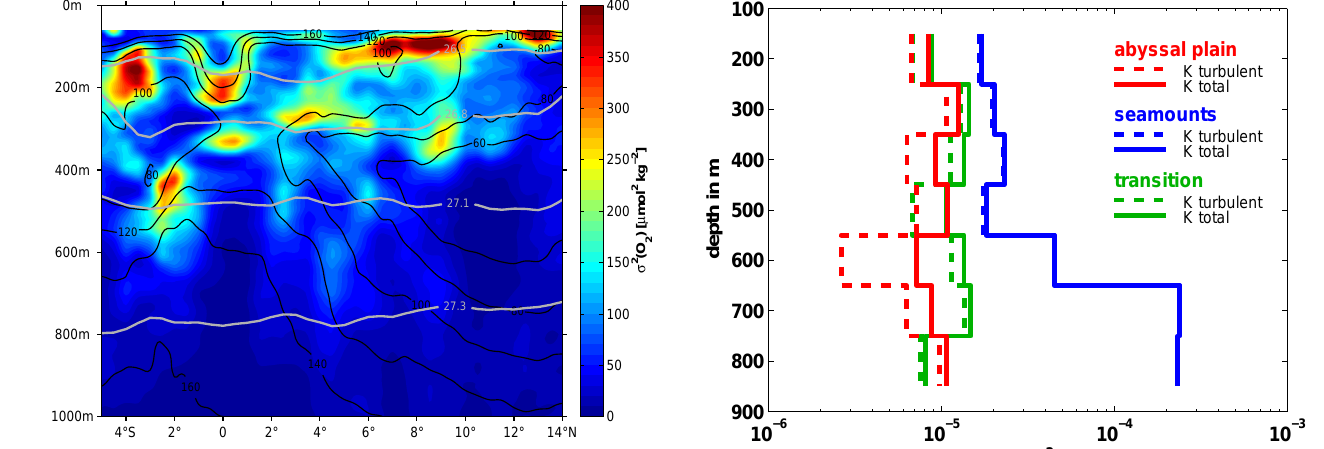
Figure 10. Oxygen variance along 23 ◦ W from repeat ship sec- tions. The analysis was done on isopycnal surfaces and the re- sults were projected back onto depth coordinates. Grey contours mark potential density (kgm − 3 ); black contours mark mean oxy- gen (µmolkg − 1 ).